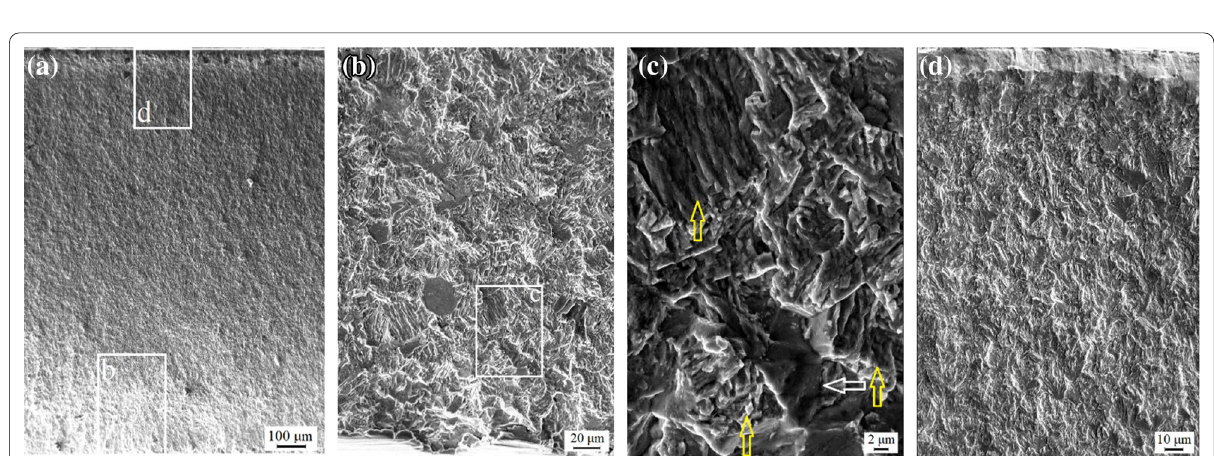
Figure 7 Cross-sectional micrographs of fatigue failure specimens: a 0.8 failed at 1.68